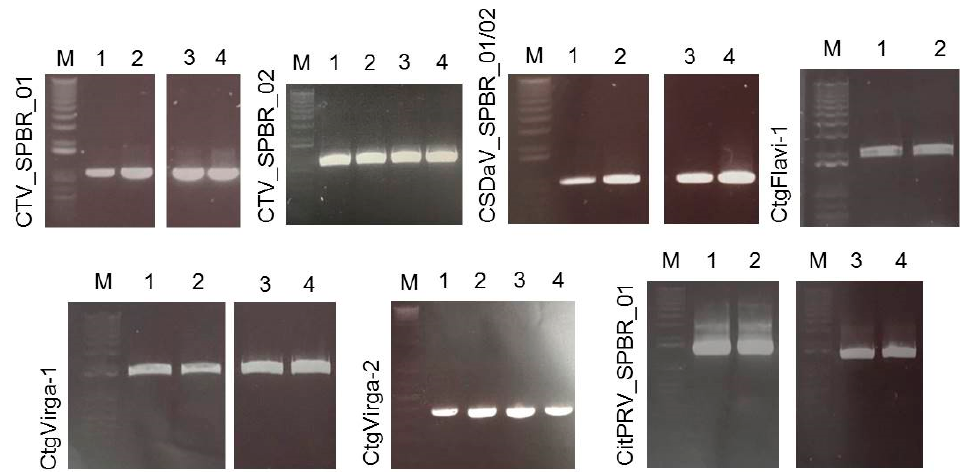
Figure 4. Electrophoretic analysis of virus-specific PCR products amplified from total RNAs extracted from citrus collected in a CSD-affected region. The expected size of the amplified PCR products are: 1001 nucleotides (nt; CTV_SPBR_01); 1095 nt (CTV_SPBR_02); 974 nt (CSDaV); 1929 nt (CtgFlavi-1); 1936 nt (CtgVirga-1); 384 nt (CtgVirga-2) and 1363 nt (CitPRV). 1 and 2 , RNAs from